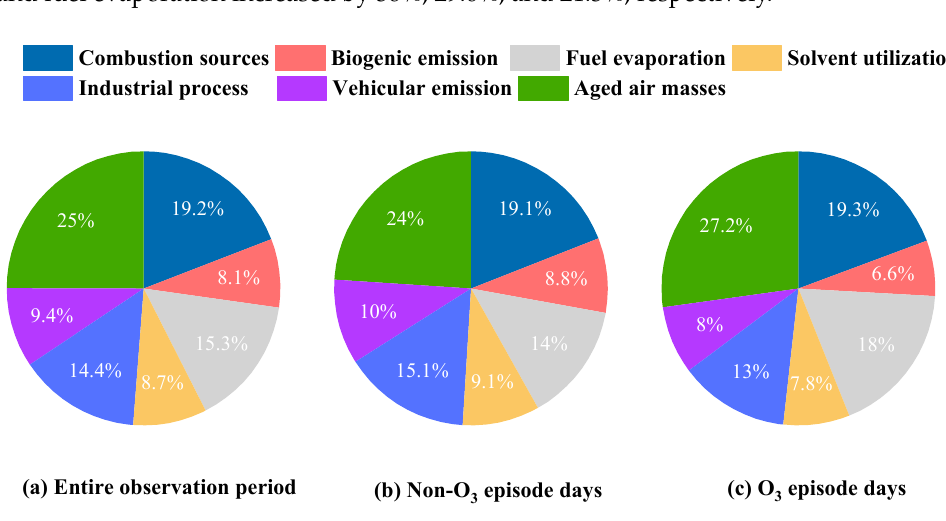
Figure 5. Contribution of each source to VOCs at di ff erent periods.